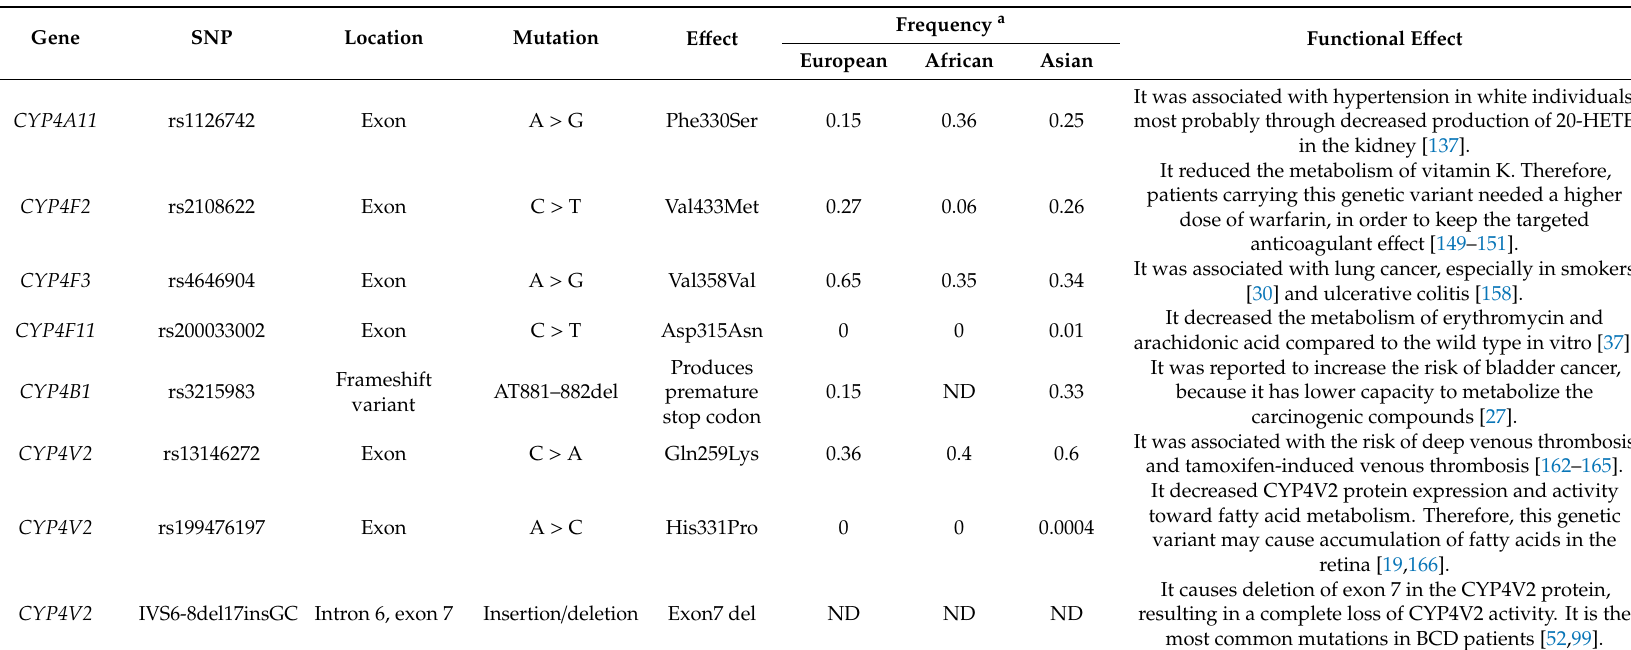
Table 2. Representatives of genetic polymorphisms in CYP4 genes with clinical impact and their frequencies in di ff erent ethnic